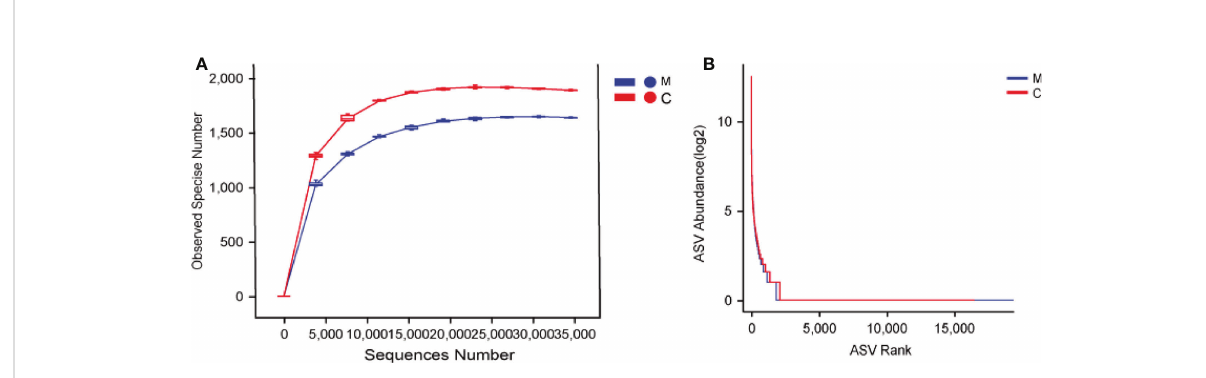
FIGURE 1 Dental plaque bacterial community structure differs between groups. (A) Rarefaction curves, (B) Rank abundance curves. The M and C groups are colored in blue and red, respectively.